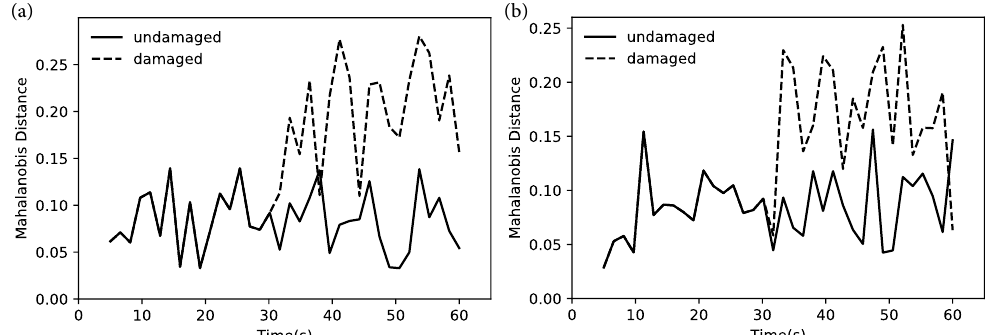
Figure 6. Change in Mahalanobis distance between the feature vectors of the damaged and undam- aged states. ( a ) Simulated linear system and ( b ) simulated bilinear system. Damage introduced at t = 30 s.